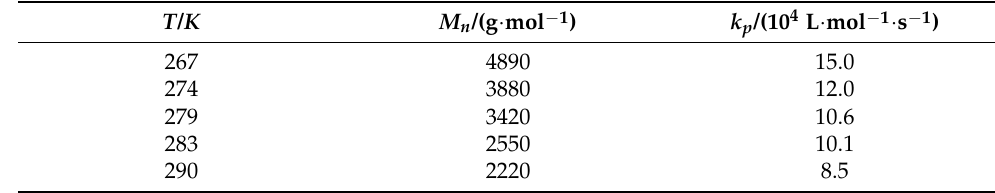
Figure 5. Calculation flow chart for the kinetic parameters. Table 2. The calculated values of k p based on T and experimental M n